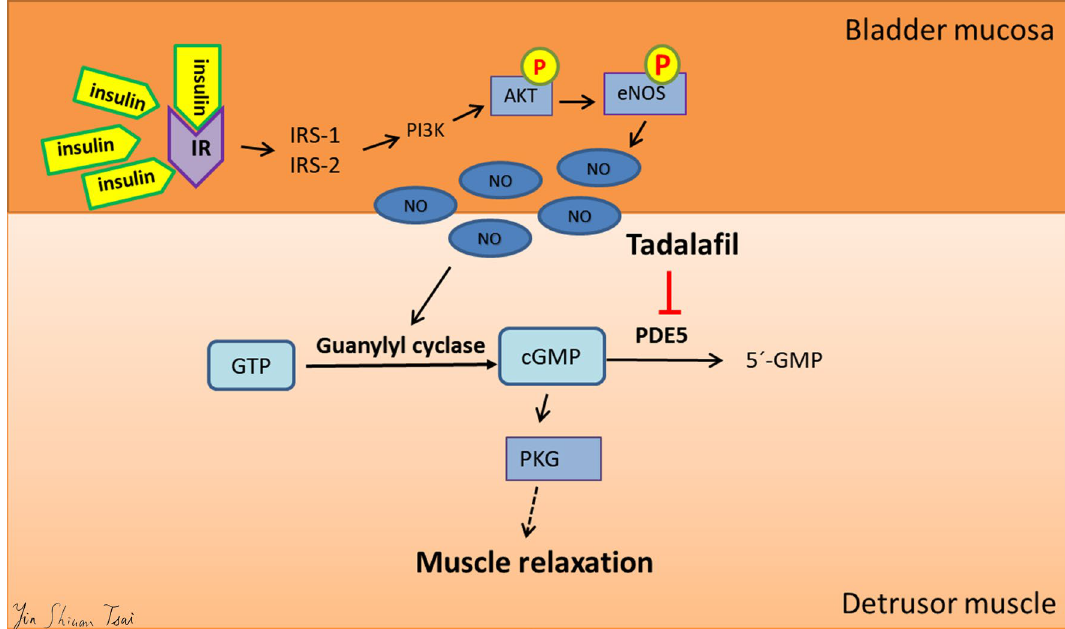
Figure 4. Schematic diagram illustrating the molecular events that take place in the bladder mucosa and detrusor, leading to the impairment of insulin-induced detrusor relaxation in metabolic syndrome (MS)- associated overactive bladder. High fructose diet induces hyperphosphorylation of IRS1 and IRS2, resulting in insulin resistance and the subsequent downregulation of the PI3K/Akt/eNOS signalling pathway and NO production in the mucosa. This is followed by the suppression of cGMP activity, and expression and level of PDE5 in the detrusor, leading to impairment of insulin-induced detrusor relaxation. Tadalafil treatment may ameliorate the MS-associated bladder overactivity through restoring insulin-activated detrusor relaxation via molecular repertories that are associated with increased eNOS phosphorylation in the bladder mucosa, restoration of urinary NO availability and detrusor cGMP